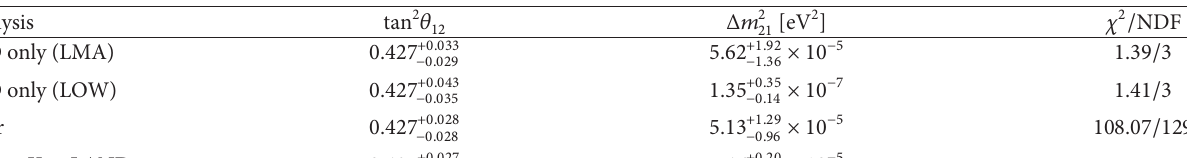
Table 7: Best-fit neutrino oscillation parameters from a two-flavor neutrino oscillation analysis. Uncertainties listed are 1 𝜎 after the 𝜒 2 was minimized with respect to all other parameters (taken from [147]).